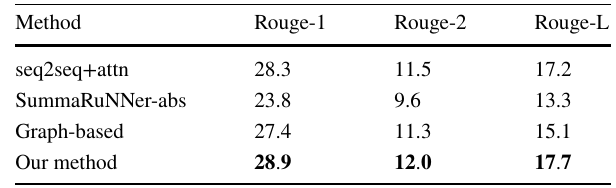
Best results are in